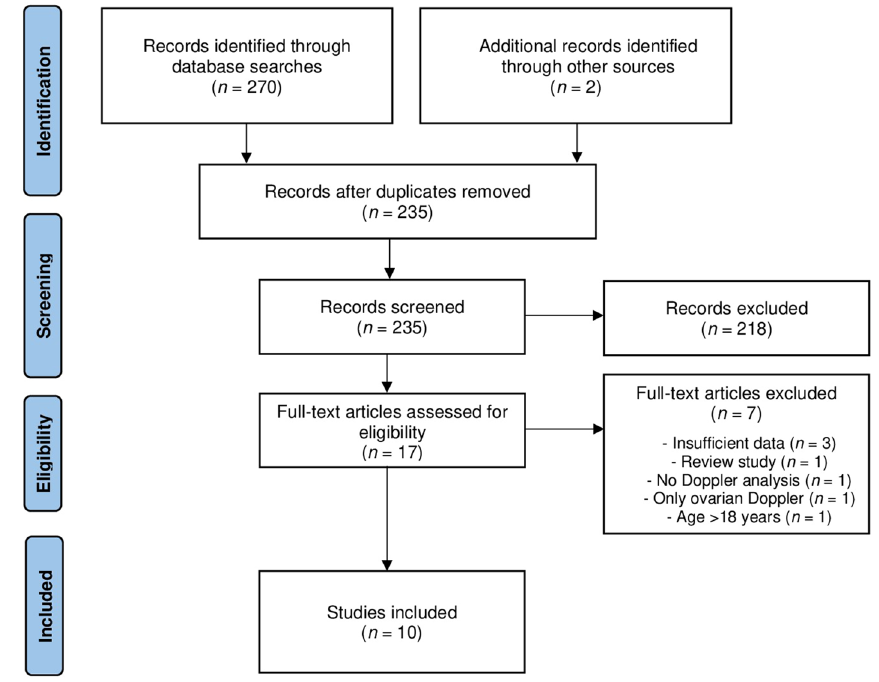
Figure 1. Study flow diagram for the scoping review